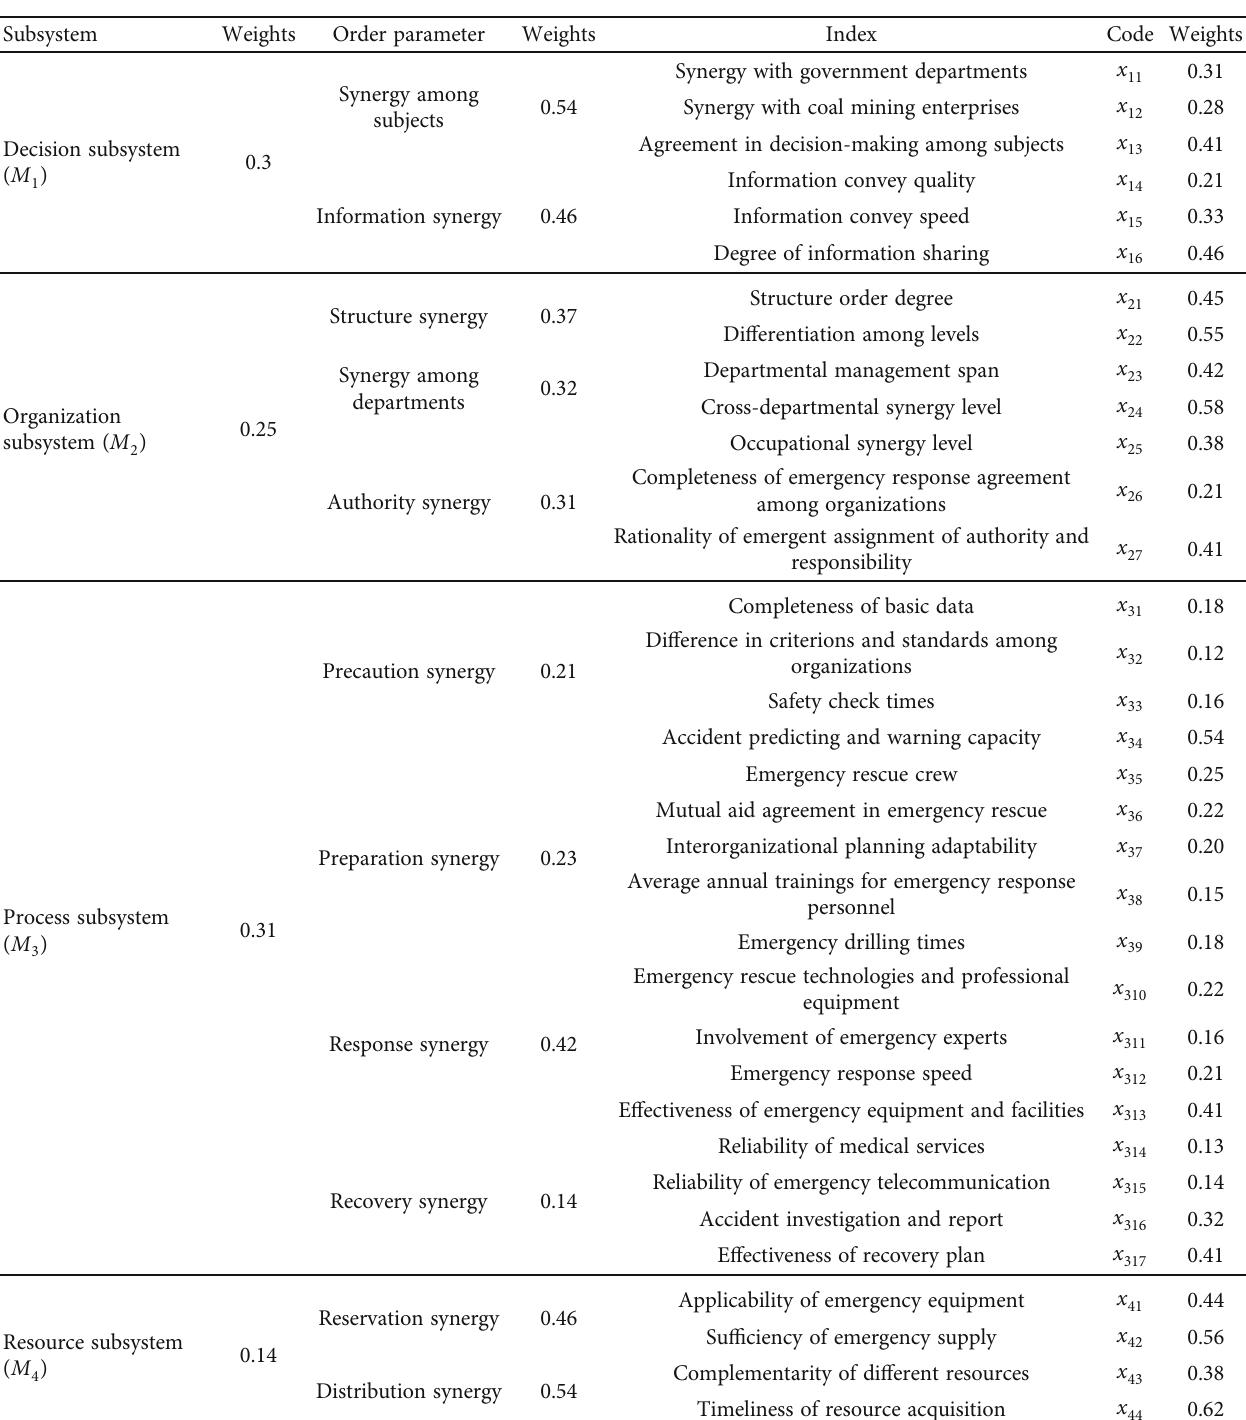
Table 3: Regional coal mine emergency system synergistic degree evaluation index